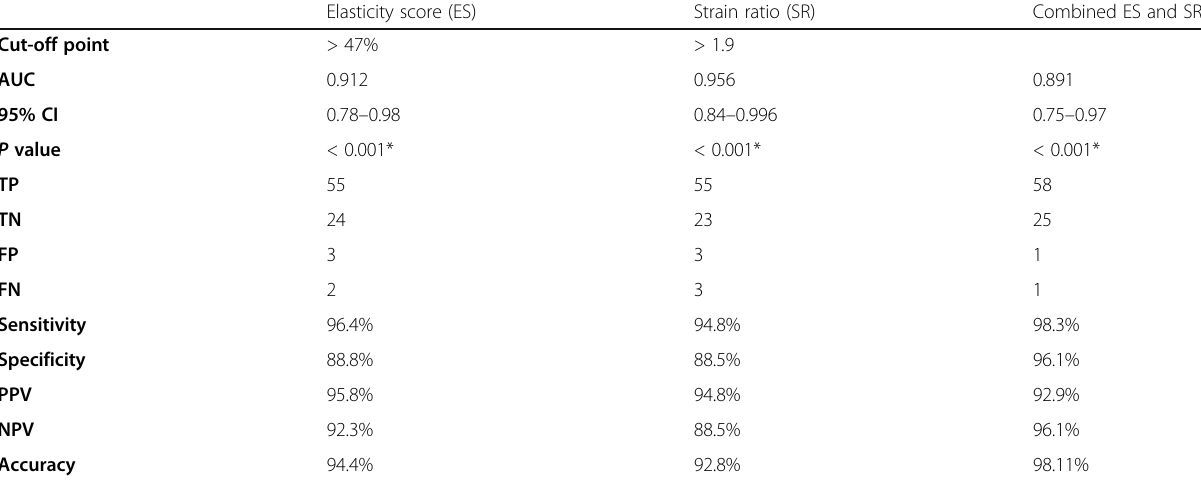
Table 4 Diagnostic performance of elasticity score and strain ratio in isolation and combined Elasticity score (ES)